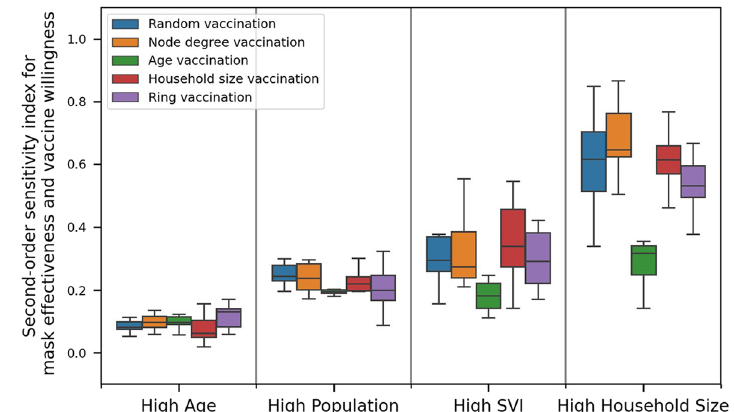
Fig. 9 Distribution of second-order sensitivity on deaths. Results are grouped by community and vaccine prioritization. Each box includes the 25th, 50th and 75th percentile for the model output, with whiskers that extend to 1.5 times the interquartile